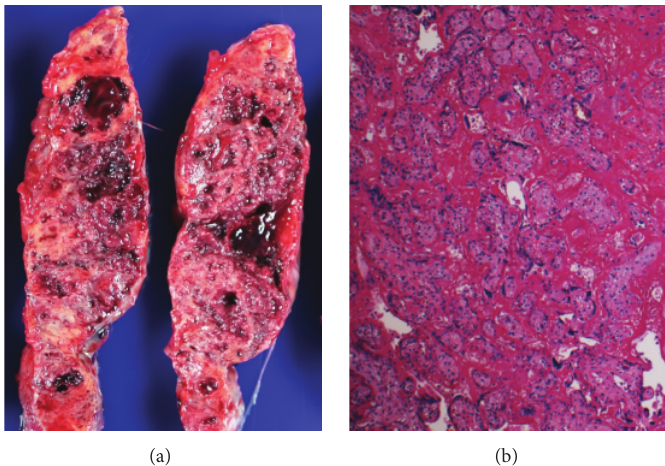
Figure 1: Placenta. Massive perivillous fibrin deposition. Cut surface of placenta with fibrous trabeculae forming a meshwork of confluent granular aggregates extending the entire thickness of the placental disc (a). Corresponding photomicrograph showing sclerotic chorionic villi encased with dense fibrin/fibrinoid material obliterating the intervillous space (b) (H&E, ×